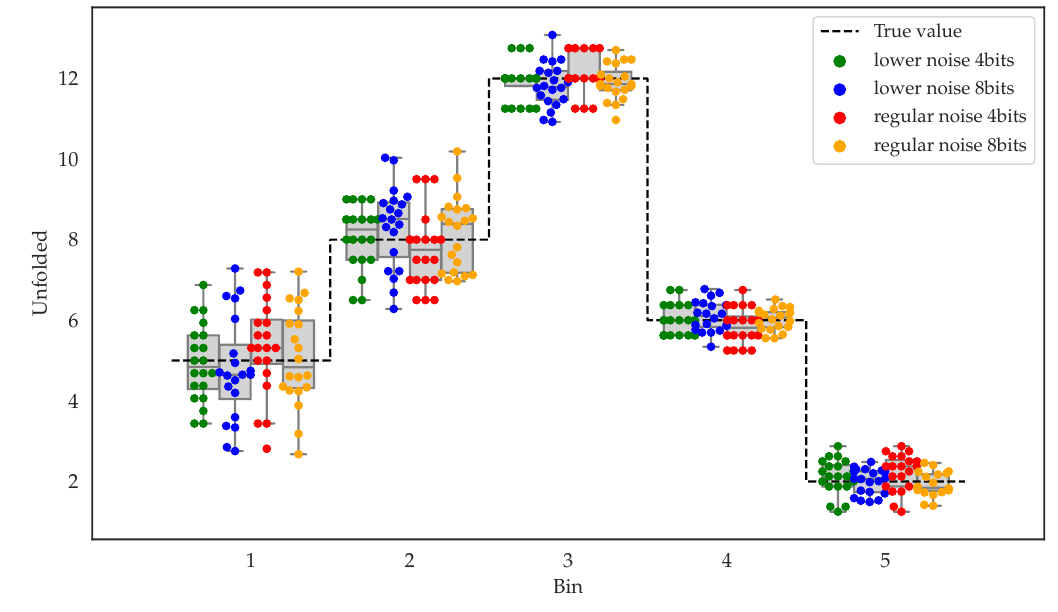
Figure 4 . Truth-level distribution of pseudo-data, unfolded with either a 4- or 8-bits encoding, of a peaked spectrum. The data corresponding to runs submitted to the QPU are averaged over 20 executions with 5000 reads each. The maximum chain length in the best embedding is 7 and 15 qbits respectively. The 8-bit encoding allows a more (cid:12)ne-grained estimation of the unfolded